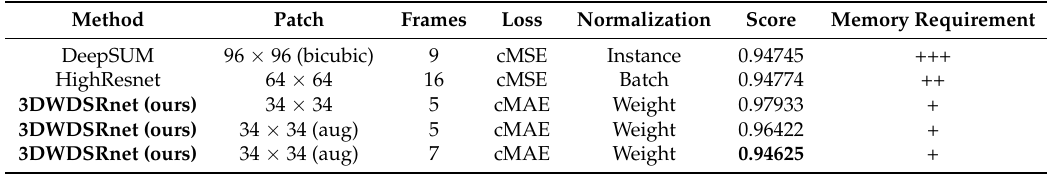
Table 1. Scores obtained in the Kelvin ESA Competition public leaderboard (February 2020). Scores are normalized by baseline; less is better. Symbol (+) refers to the memory requirements based on the number of frames, the image patch size, and the filters